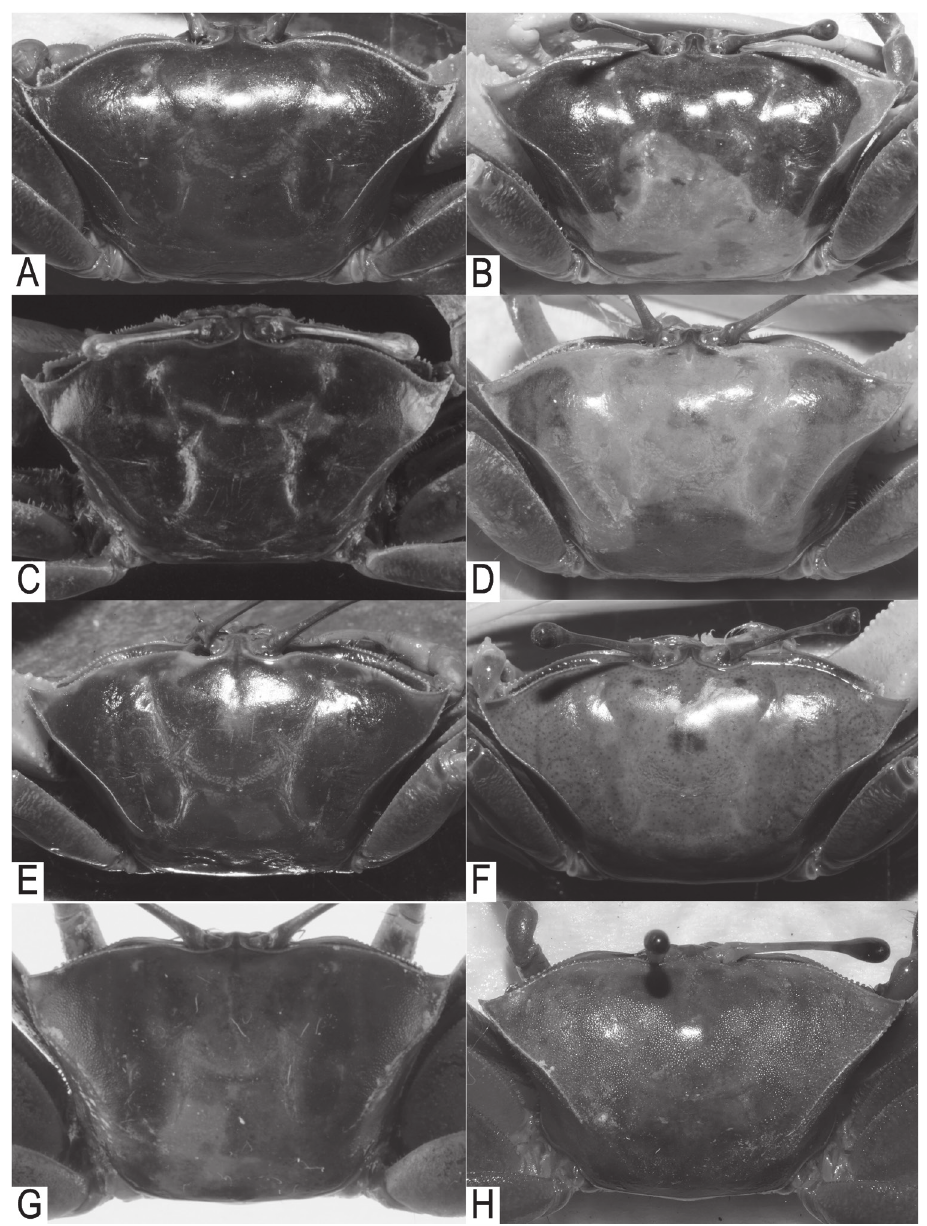
Figure 7. Carapace morphology. A, C, E, G Tubuca alcocki sp. n., B, D, F, H T. urvillei (H. Milne Edwards, 1852). A holotype male (CW 30.1 mm, ZRC 2017.1278; Thailand) B male (CW 34.9 mm, NCHUZOOL 14895; Kenya) C male (CW 29.5 mm, NCHUZOOL 14896; Ranong, Thailand) D male (CW 29.7 mm, ZRC 1999.1107; Mayotte) E male (CW 27.8 mm, NCHUZOOL 14905; Thailand) F male (CW 27.9 mm, NCHUZOOL 14895; Kenya) G female (CW 22.6 mm, NCHUZOOL 14900; India) H female (CW 22.9 mm, SMF 19985;